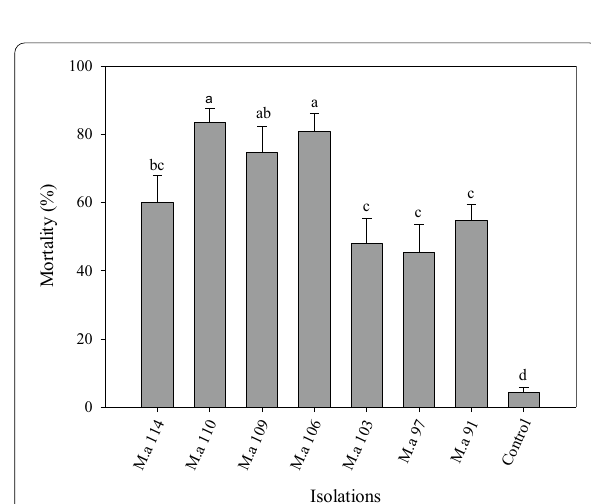
Fig. 2 Mean ( standard error) mortality of Tetranychus urticae adults ± exposed to 1 10 7 conidia mL − 1 of seven isolates of Metarhizium × anisopliae under laboratory conditions. Bars with different letters are significantly different (Tukey test, n 5, p < =